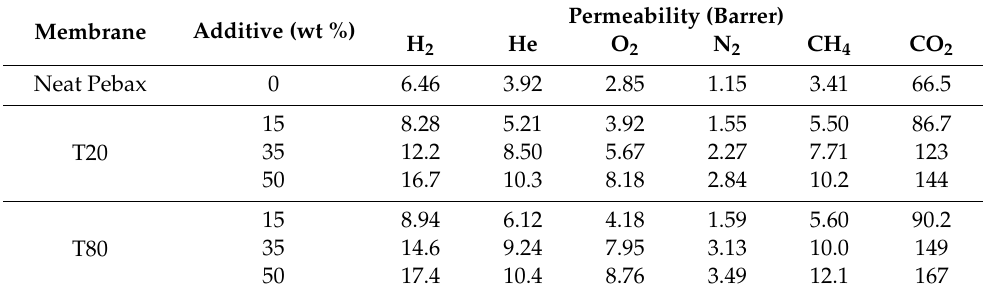
Table 3. Pure gas permeability on neat Pebax ® 1657 and Pebax ® 1657 / Polysorbate dense membranes.